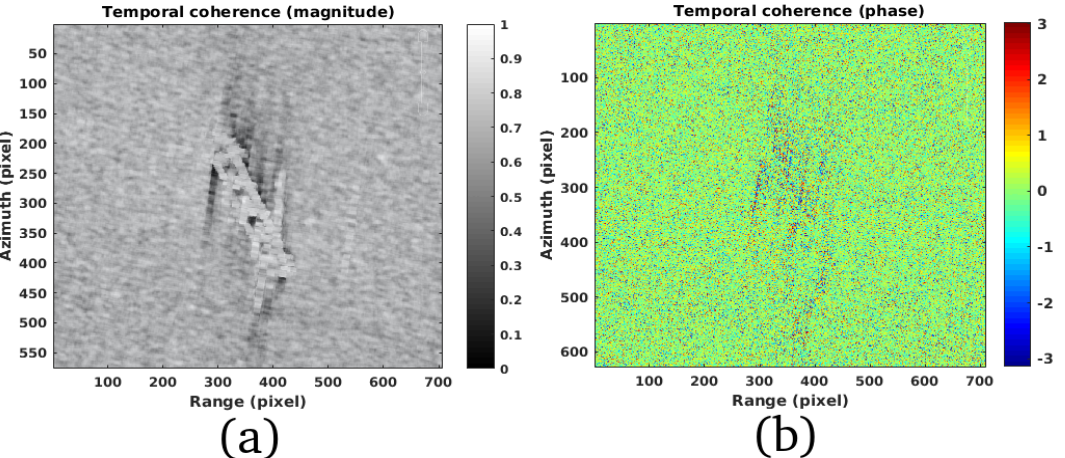
Figure 7. ( a ): Infra-chromatic coherence ROI (magnitude). ( b ): Infra-chromatic coherence ROI